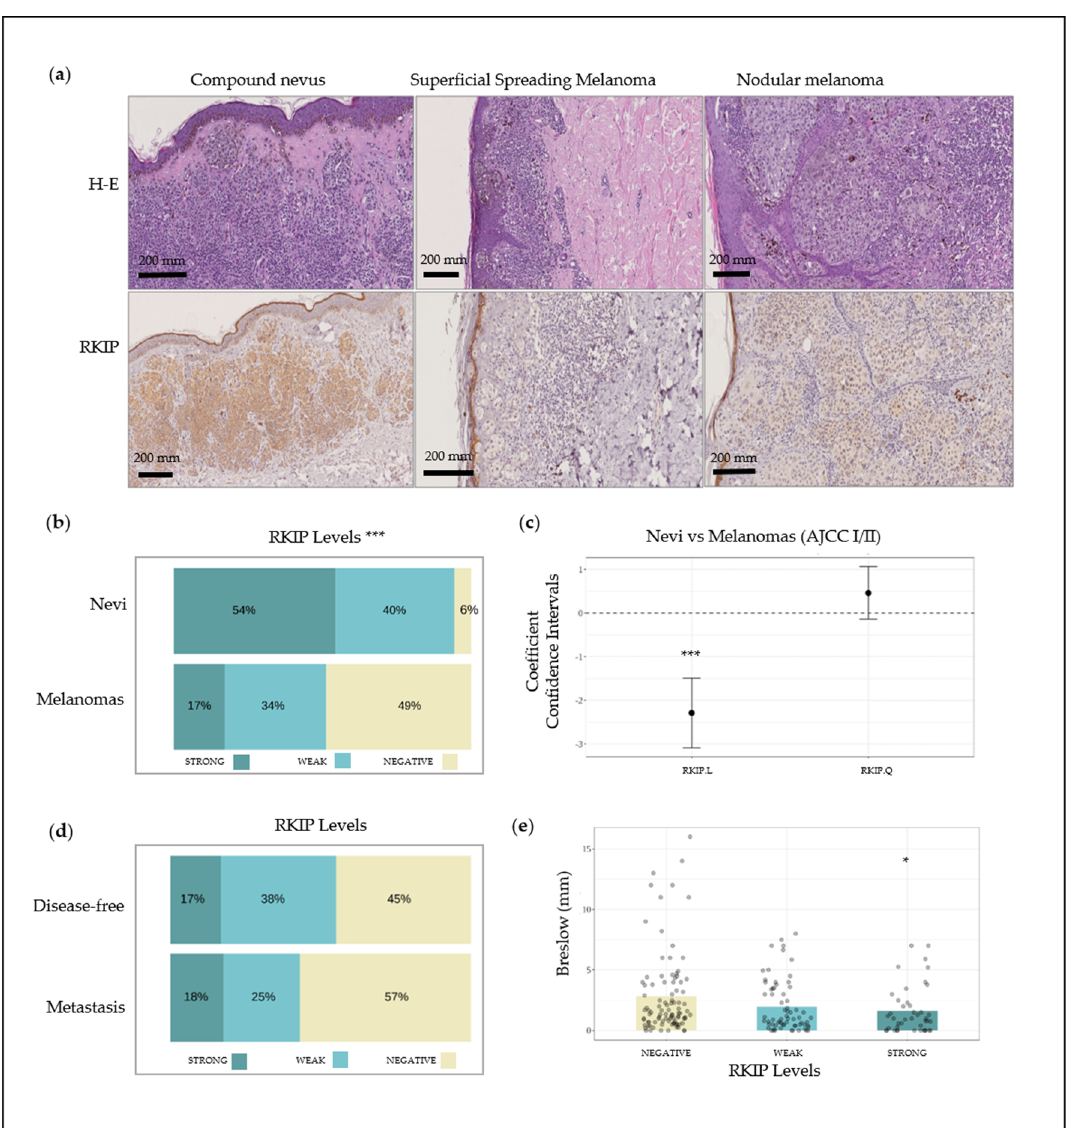
Figure 1. Raf Kinase Inhibitor Protein (RKIP) expression in FFPE biopsies from patients. ( a ) Lower section of picture: IHC analysis of RKIP in normal melanocytes from a compound nevus, superficial spreading melanoma and nodular melanoma. Upper section of picture: Hematoxylin-Eosin staining (H-E); ( b ) RKIP staining distribution on nevus and melanoma tissue; ( c ) Coefficient confidence intervals for RKIP protein expression between nevus and melanoma samples; ( d ) RKIP staining distribution on histological sections of melanoma in stages I and II from patients who remained disease-free during follow-up versus patients who developed metastasis; ( e ) Kruskal–Wallis one-way analysis of Breslow index with respect to RKIP expression. * q < 0.05, *** q < 0.001.